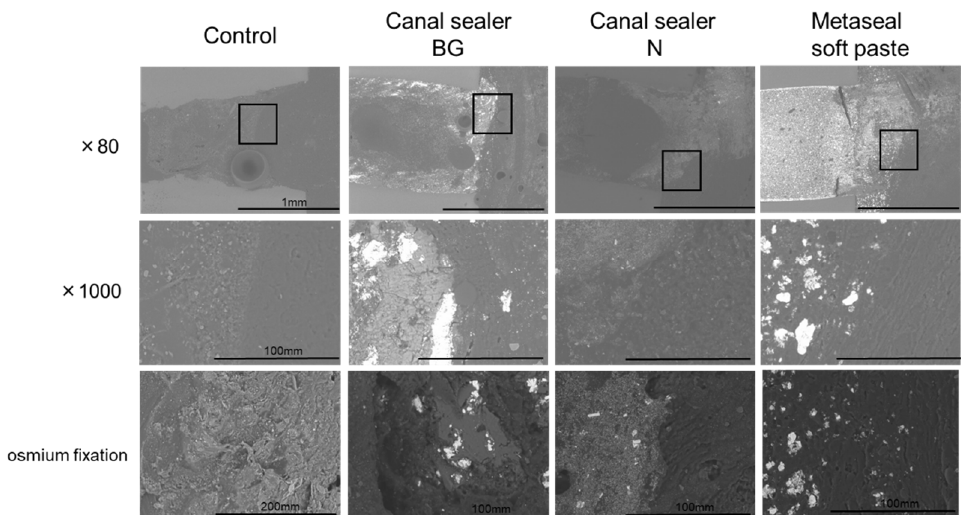
Figure 3. Scanning electron microscopy. The subcutaneous tissue around the RCO sealer was resin- embedded and analyzed (n = 3 per material). The image with high magnification is the enlargement of the black box in the image with low magnification. The bottom images correspond to osmium fixation, which was used to enable subcutaneous tissue observation. RCO: root canal obturation.